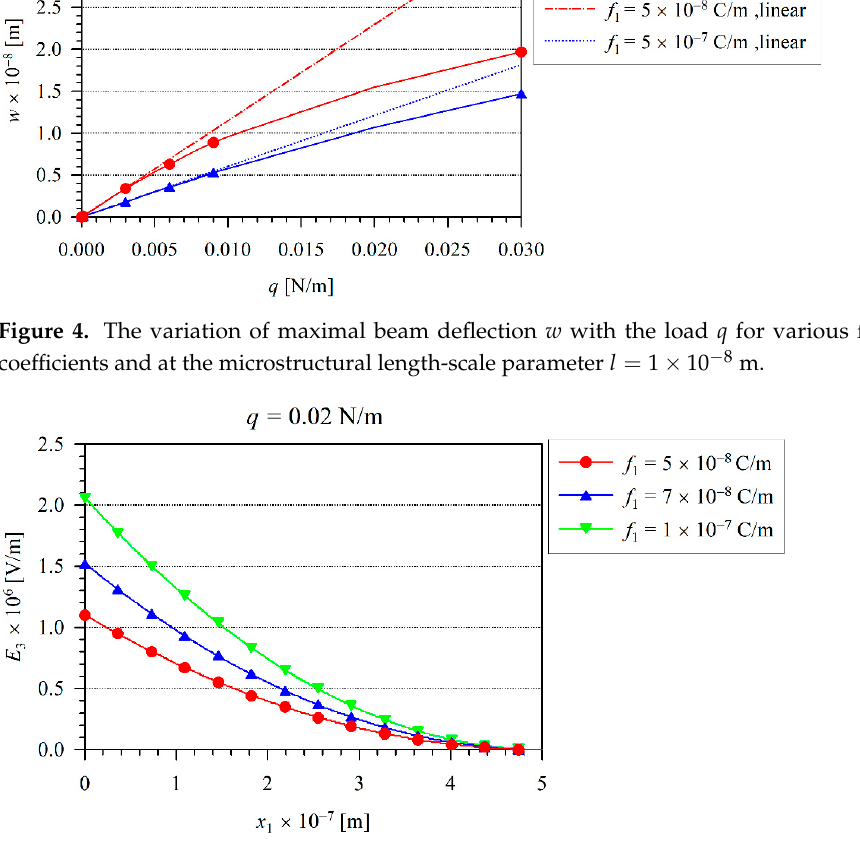
Figure 5. The variation of the electric field E 3 along x 1 for a nonlinear case.